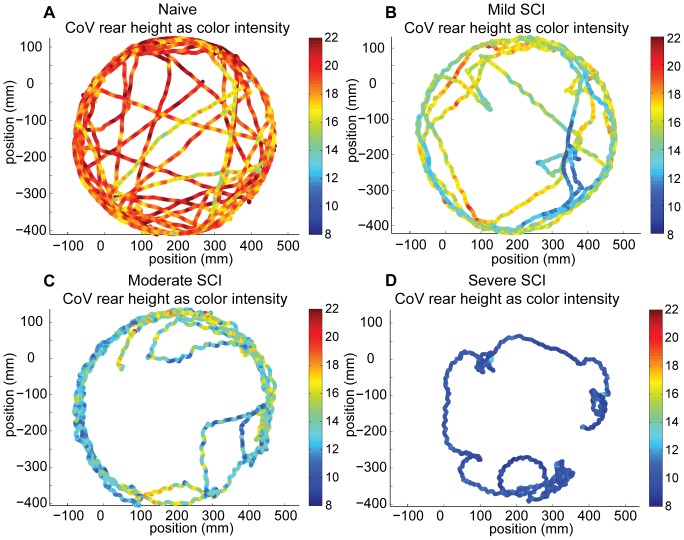
Top-down view of movement paths of a naïve and 3 SCI mice of different severities.These animals are representative of the distance traveled in an open-field trial for each group. Each dot represents the position of the mouse rear CoV in the open-field environment at 0.01 s intervals during the 2-min long trial. The color of the dot indicates the height of the rear CoV, and the rear CoV was highest (denoted by red) for the naïve mouse and lowest (denoted by blue) for severe SCI.